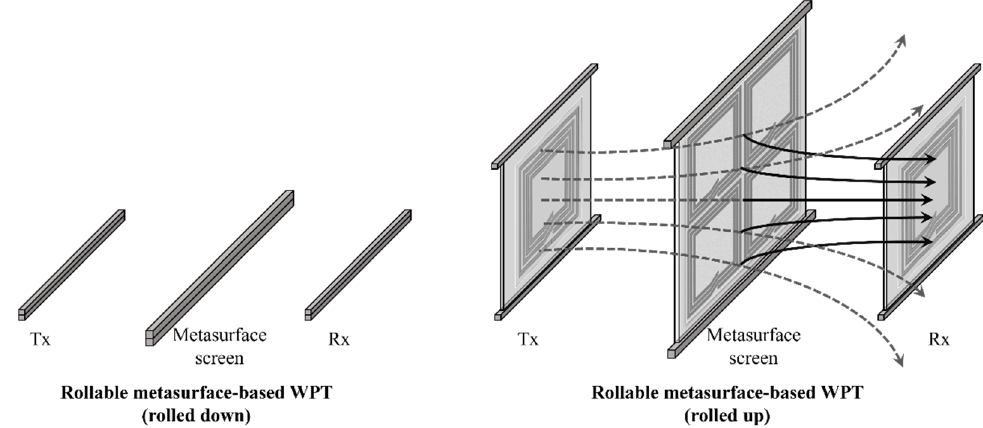
Figure 1. Conceptual illustration of the rollable MS-based WPT system.